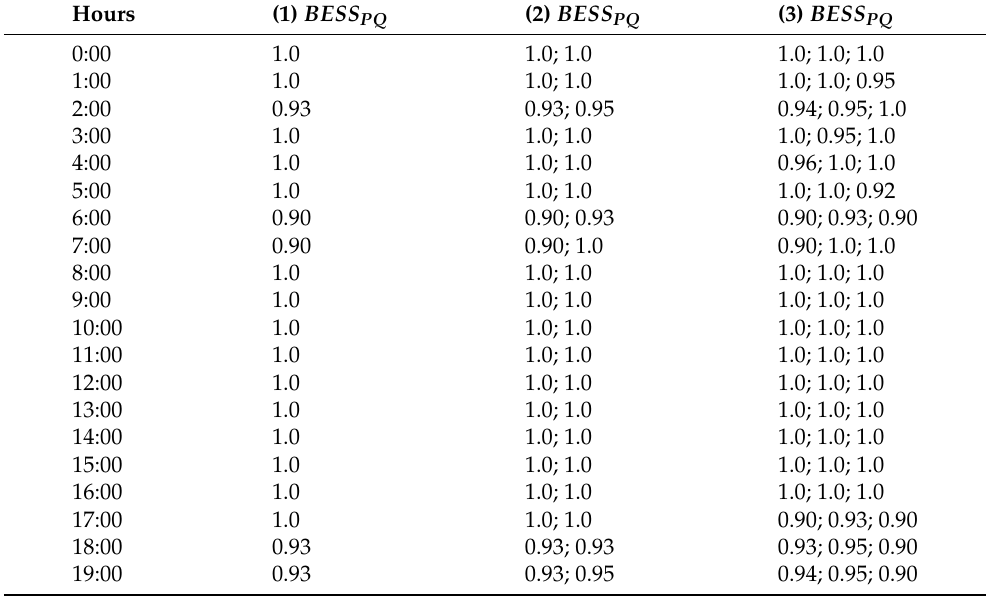
Table 3. Adjustment of power factor according to number of